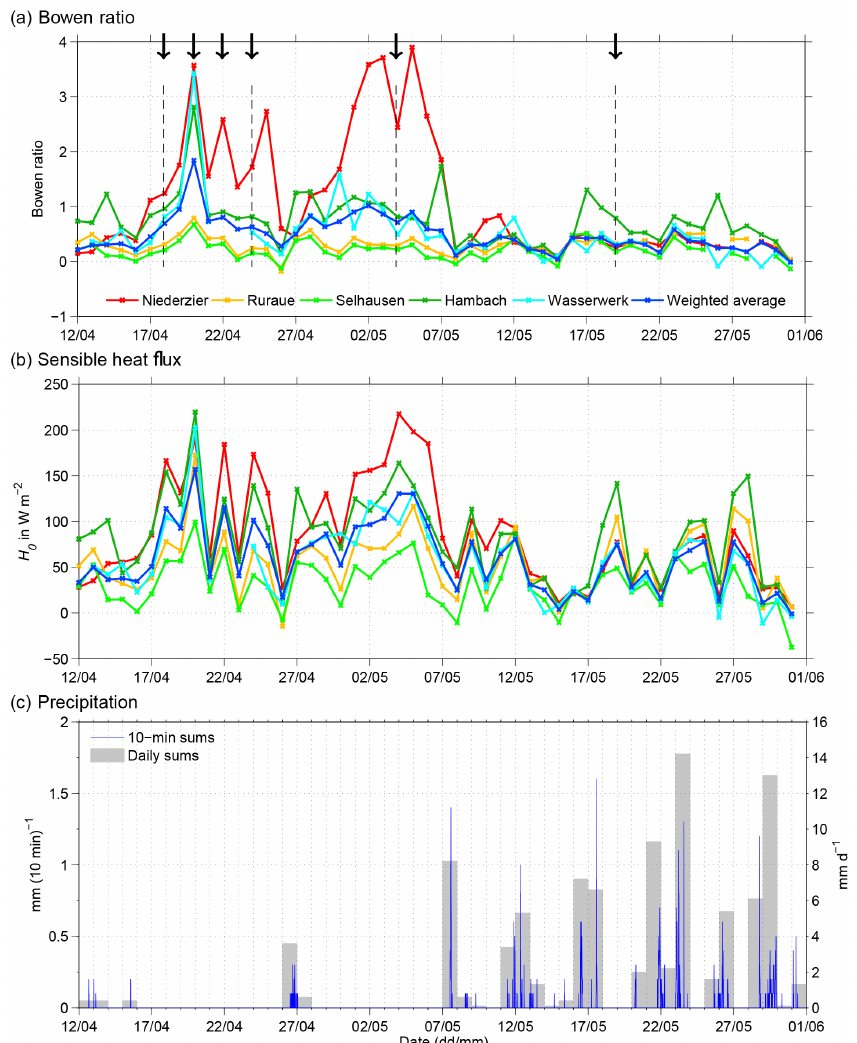
Figure 2. (a) Bowen ratio for all energy balance stations as well as for the weighted-averaged fluxes (weighted with the area fraction of each land-use class), calculated from daily averaged values of surface fluxes for 09:00–15:00UTC; black arrows denote the selected days; (b) sensible heat fluxes H 0 as used for calculation of Bowen ratio in (a) ; (c) precipitation from rain gauge measurements at